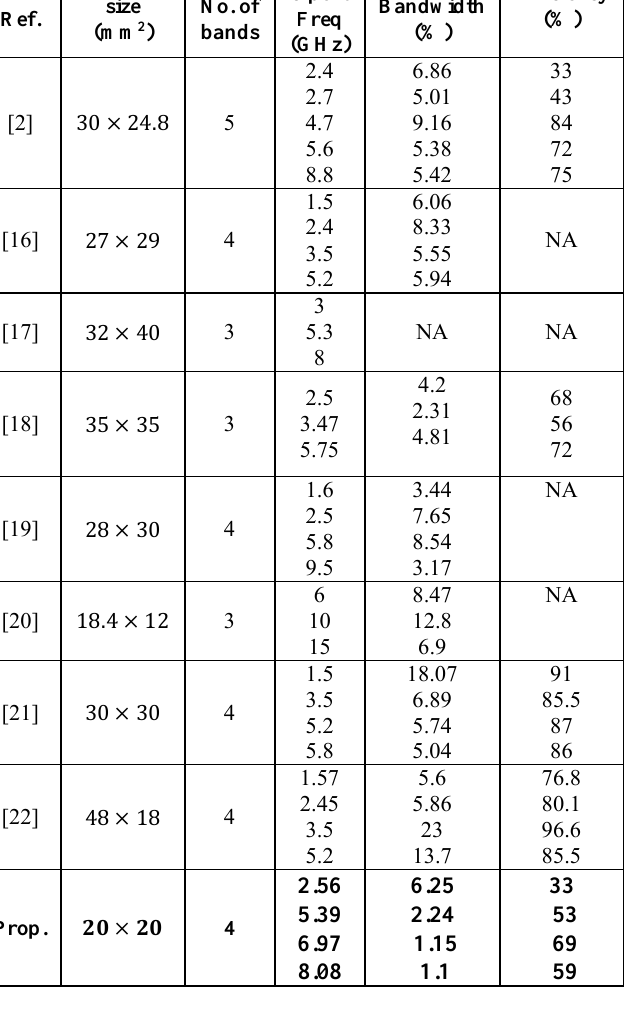
Table 3. Comparision of proposed configuration with others present in literature Ref.